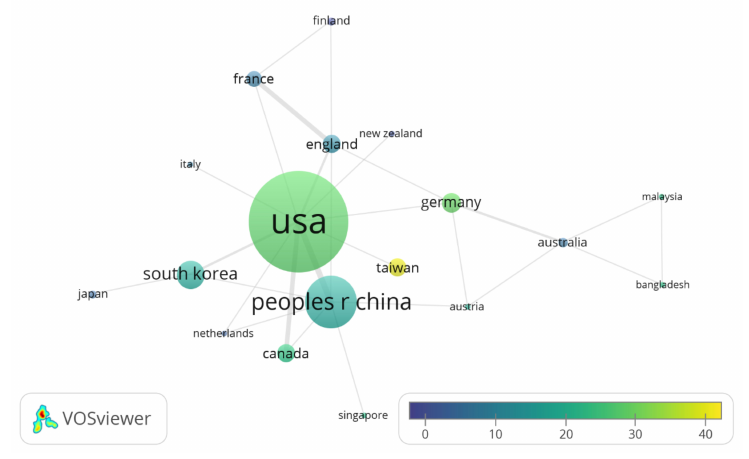
Figure 3. Country level co-authorship